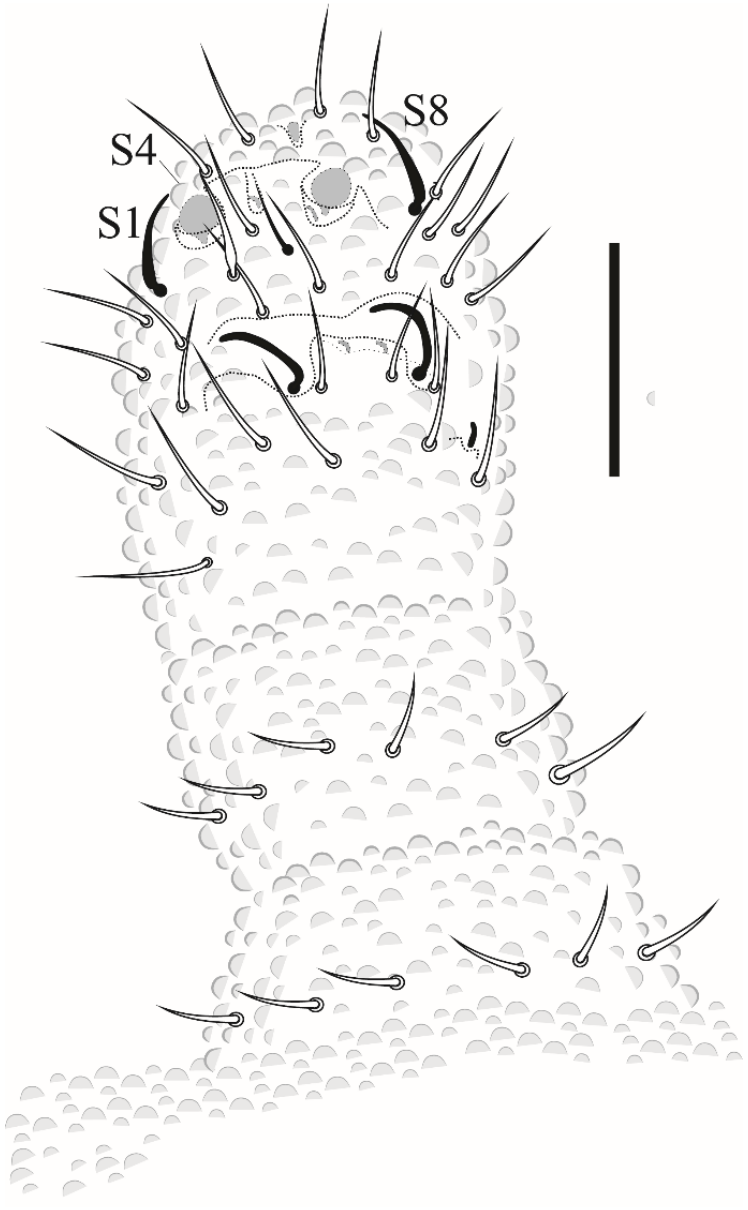
Figure 19. Willemia insularum sp. nov. 33, dorsal view of antenna. Scale bar: 10 µm. Eyes and a0 chaetae absent, PAO with 7–8 vesicles (Figure 20a). Head dorsal (Figure 20b). Prelabrum/labrum with 2/534 chaetae (Figure 21a). Along cephalic groove 3 + 3 chaetae (Figure 21b).